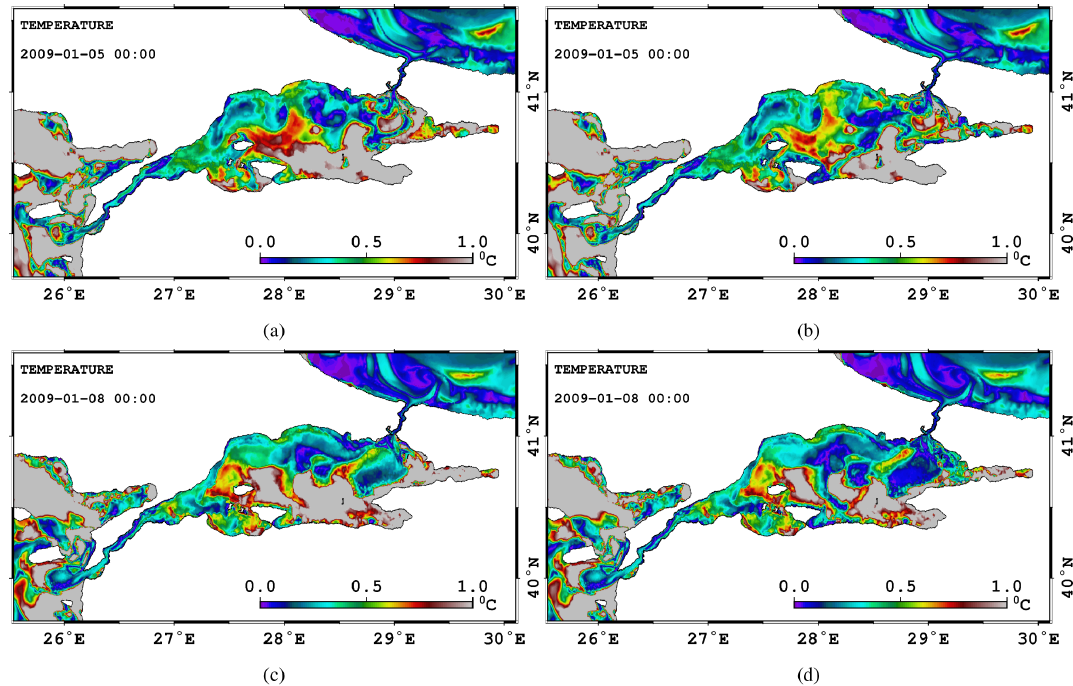
Figure 12. RMS of the difference between NR and prior temperature at the first 10m. Comparison of FB001 (a, c) and FB002 (b, d) is shown for 5 January 2009 (a, b) and 8 January 2009 (c, d) . RMS of difference is higher than 1 ◦ C in the gray